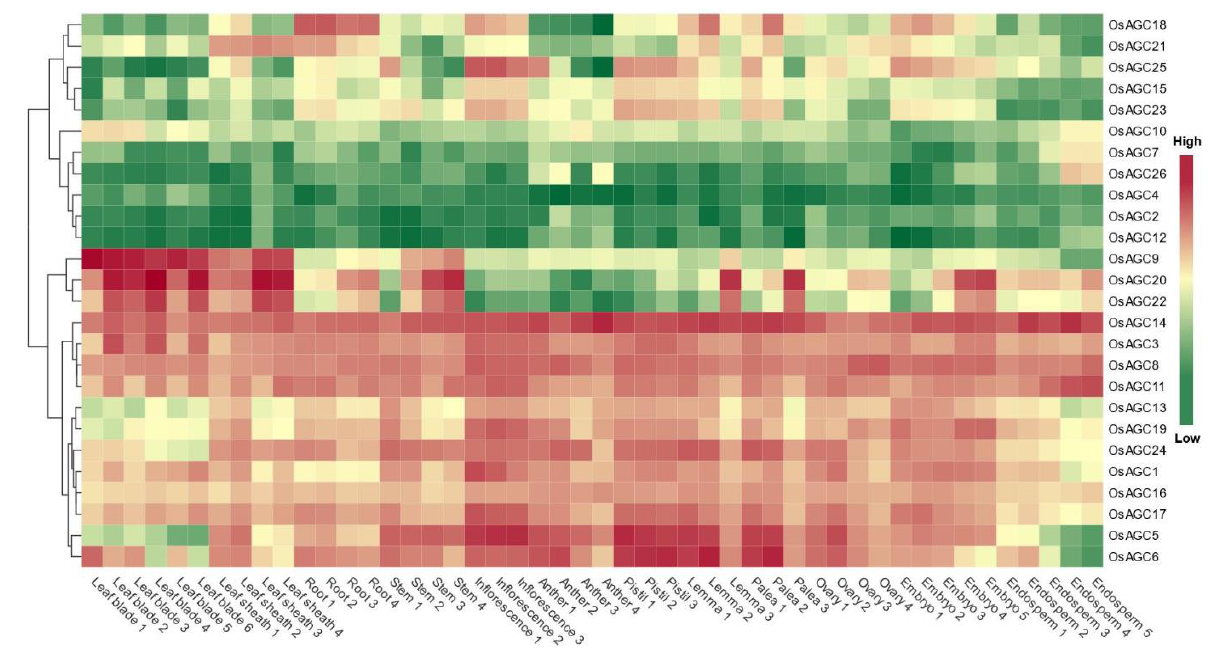
Figure 6. Expression patterns analysis of OsAGCs in O. sativa , japonica .